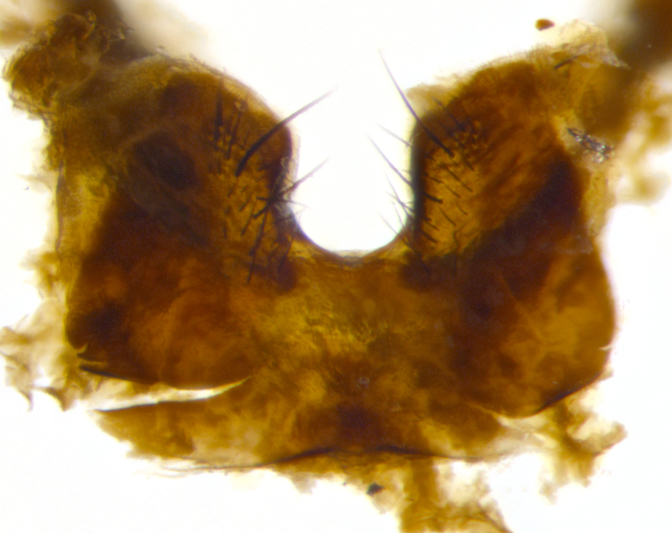
sternite 5, ventral view